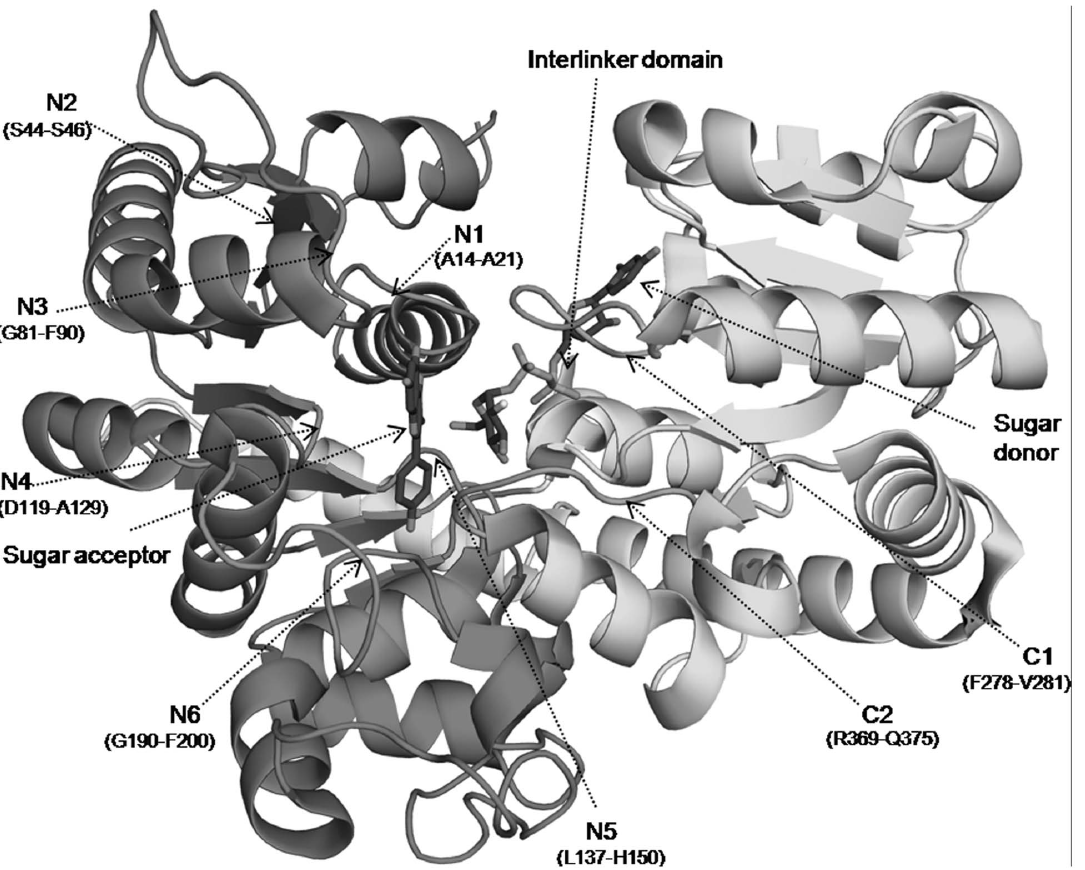
Figure 6. Conserved regions near the acceptor binding region. Ribbon view of UGT from V. vinifera with docked acceptor and sugar donor in stick form is shown. Six conserved regions from N1 to N6 at the NTD and two regions C1 and C2 at the CTD marked with an arrow play a crucial role in holding the acceptor in the binding pocket.